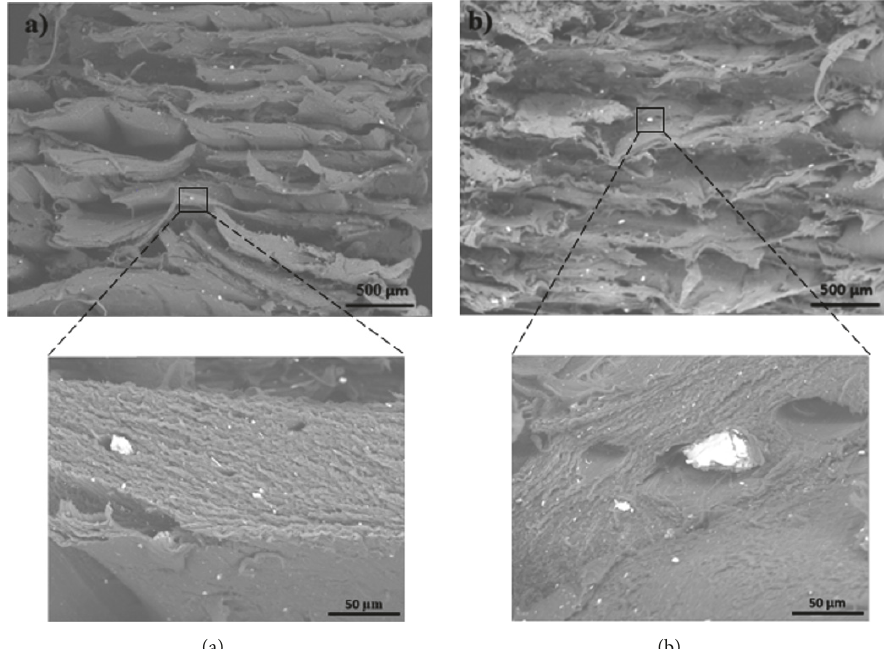
Figure 8: SEM micrographs of tensile specimens fabricated from ABS:SEBS-g-MA loaded with 10% by weight P-glass and printed at (a) 240 ∘ C and (b) 280 ∘ C.